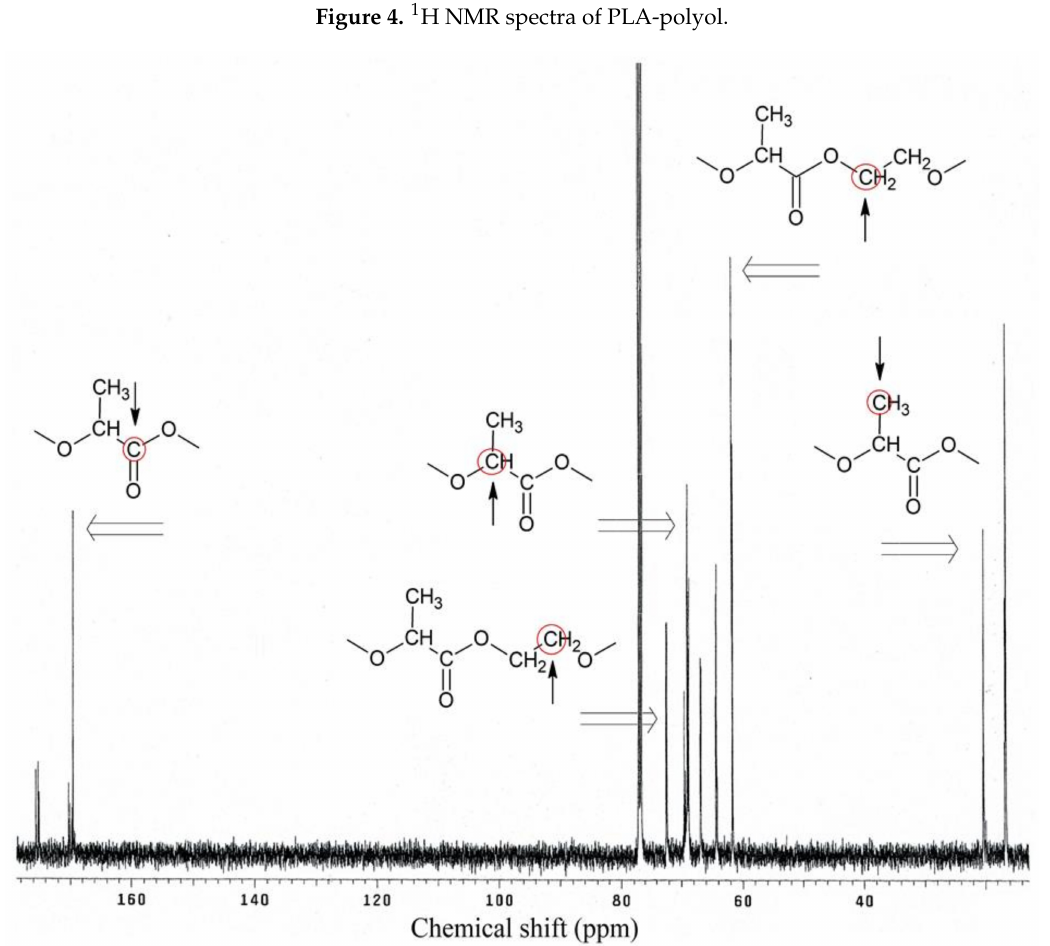
Figure 5. 13 C NMR spectra of